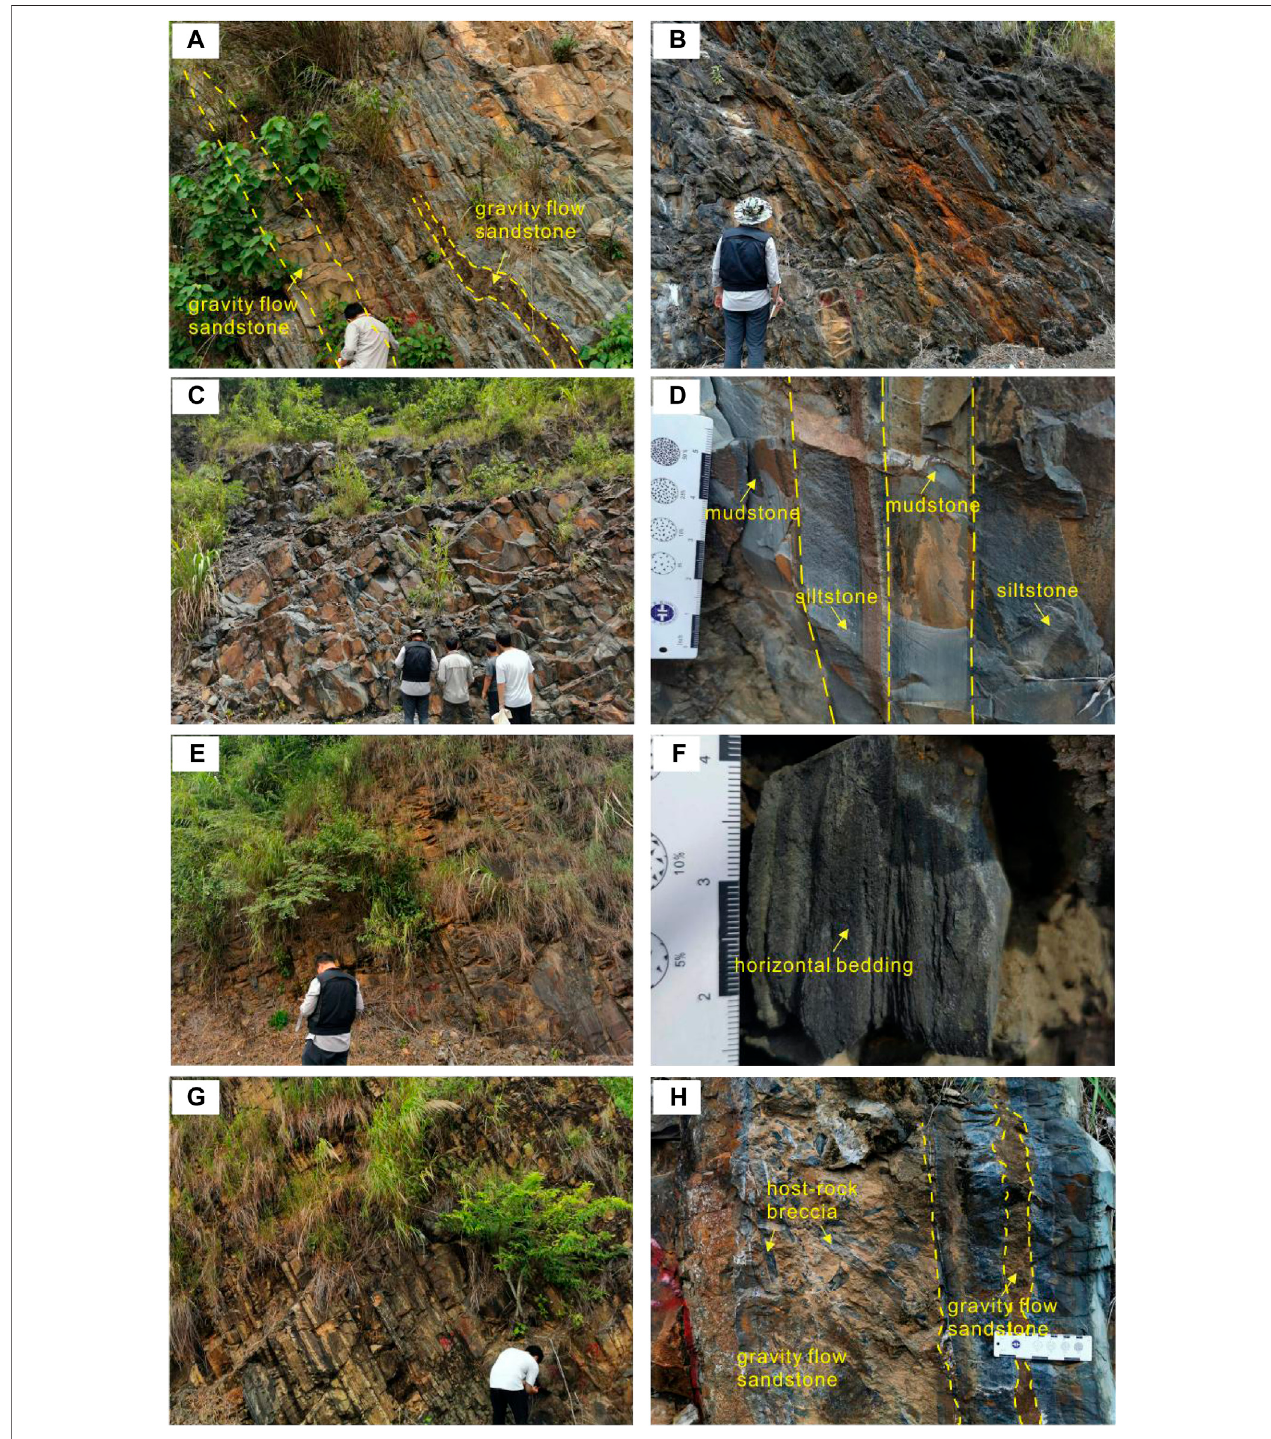
FIGURE 2 | Macroscopic sedimentary characteristics for Linghao Formation from typical outcrops in the central Nanpanjiang basin. (A) Gravity fl ow sandstone in black shale, lower Ling 1 member, XM Outcrop. (B) Black shale with abundant organic matter in upper Ling 1 member, XM Outcrop. (C) Grey mudstone and silty mudstone with interbed of siltstone, Ling 2 member, XM Outcrop. (D) Frequent thin interbeds between siltstone and mudstone, Ling 2 member, GL Outcrop. (E) Black shale,lowerLing3member,XMOutcrop. (F) Blackshalewithhorizontalbedding,lowerLing3member,XMOutcrop. (G) Chertwithhorizontalbedding,upperLing 3 member, XM Outcrop. (H) Gravity fl ow sandstone in chert and host-rock breccia in gravity fl ow sandstone, upper Ling 3 member, XM Outcrop.